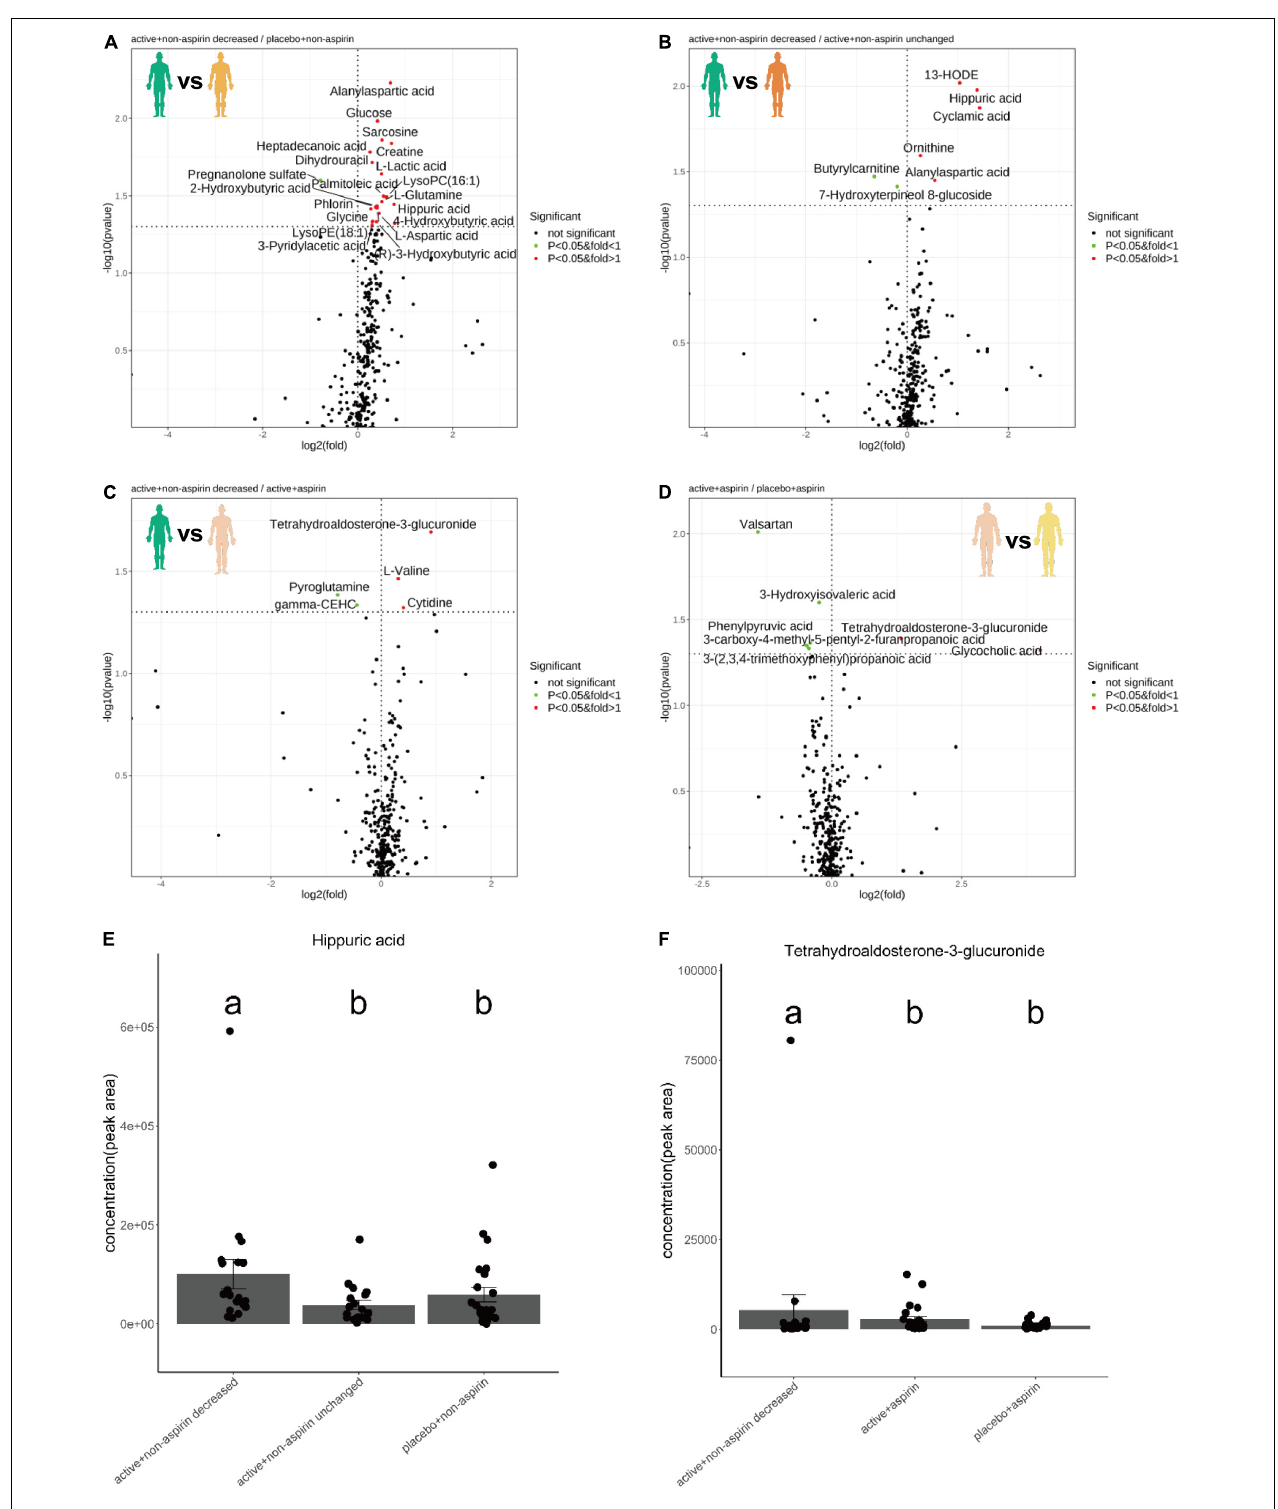
FIGURE 2 | Volcano plots illustrate serum metabolite changes at 24-month in selected pairwise comparisons of clinical groups, which included (A) active B vitamin supplementation in non-aspirin users with reduction in CDR-SOB relative to non-aspirin users on placebo; (B) active B vitamin supplementation in non-aspirin users with reduction in CDR-SOB relative to those without changes in CDR-SOB; (C) active B vitamin supplementation in non-aspirin users with reduction in CDR-SOB relative to active B vitamin supplementation in aspirin users; (D) active B vitamin supplementation in aspirin users relative to aspirin users on placebo. Dotplots illustrate changes in the levels in (E) hippuric acid and (F) tetrahydro-aldosterone-3-glucuronide at 24 months. P -values from two-sided Dunn’s tests were displayed.